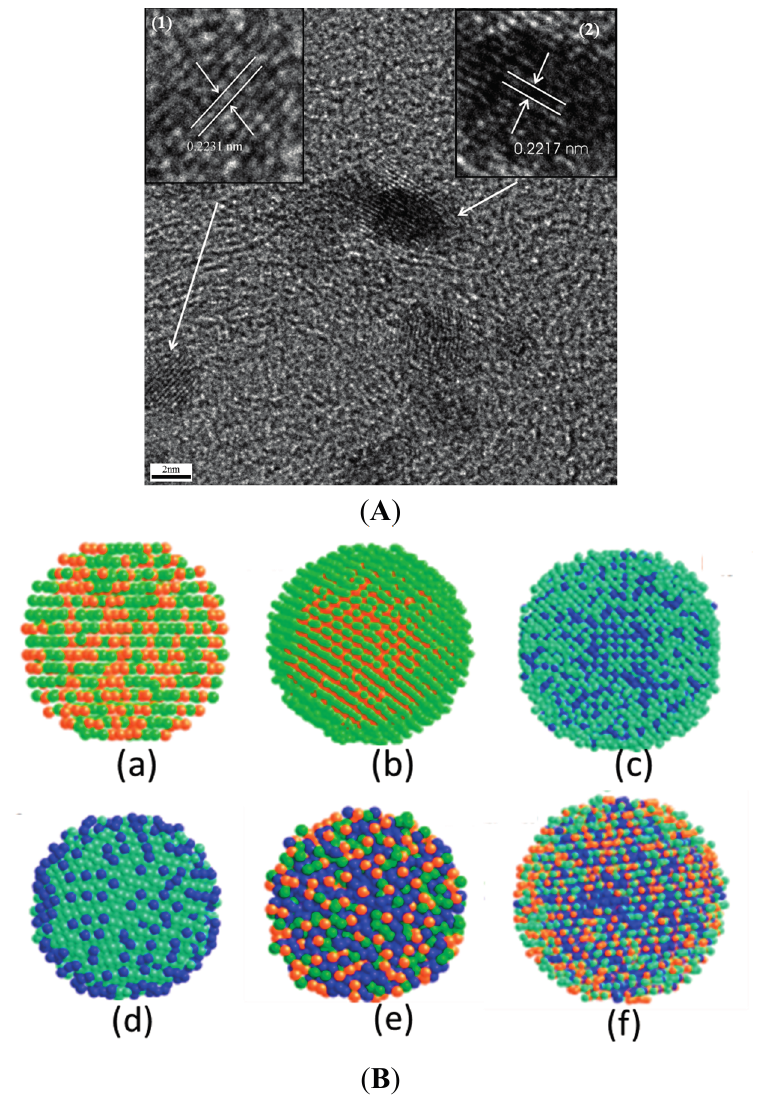
Figure 4. ( A ) HR-TEM for Pt 25 Ir 20 Co 55 and ( B ) RMC constructed models for Pt 45 Ir 55 , Pt 73 Co 27 , and Pt 25 Ir 20 Co 55 processed at 400 °C ( a , c , e , respectively) and 800 °C ( b , d , f , respectively). (Pt atoms: green, Ir atoms: orange, and Co atoms: blue). Note that the sizes of atoms are drawn not to scale to fit in the picture frame. (( A ) reproduced from reference [15] with permission. Copyright 2013, American Chemical Society, ( B ) reproduced from reference [34] with permission. Copyright 2012, American Chemical